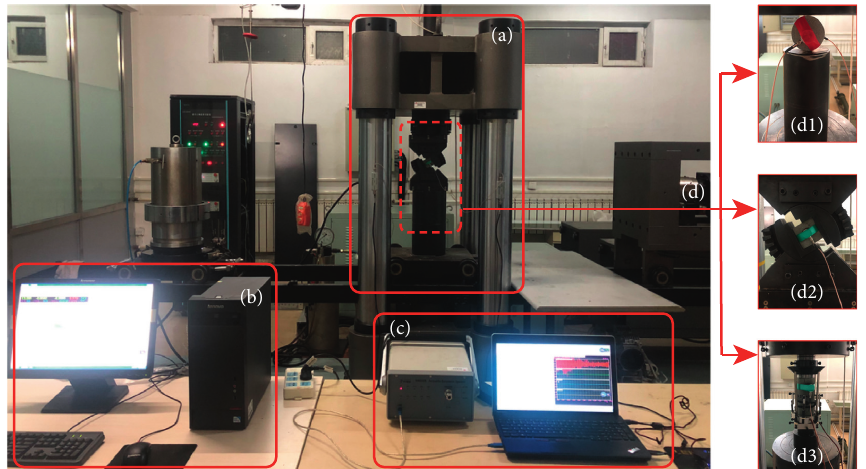
Figure 1: The experimental system. (a) SAS-2000 rock compression-testing machine. (b) Loading control system. (c) Acoustic emission (AE) monitoring system. (d1) Brazilian split. (d2) Preset angle shear. (d3) Uniaxial